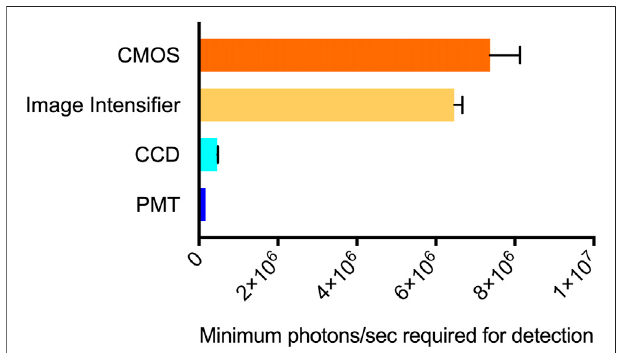
FIGURE 1 | Minimum signal detection threshold for each system. The CMOS (smartphone) system required the highest level of fl ux to detect bioluminescence at 7.37 × 10 6 photons/sec. The image intensi fi er (night vision)system wasslightlymore sensitive,requiring aminimum of6.47 × 10 6 photons/sec. The CCD and PMT systems had lower minimum detection thresholds of 4.65 × 10 5 and 1.7 × 10 5 photons/sec, respectively. n (cid:2) 3; error (cid:2)